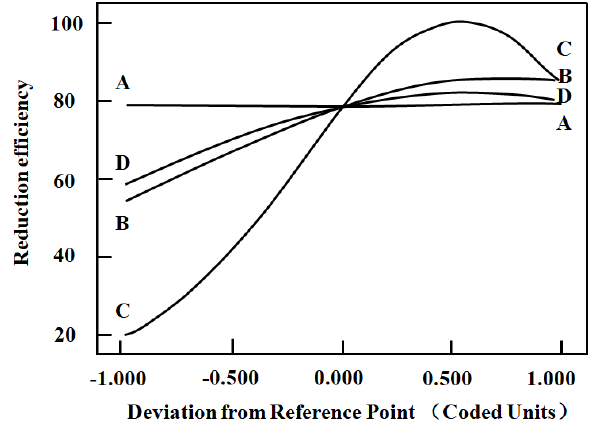
Figure 4. Perturbation plot for the precipitation efficiency of vanadium (initial pH of vanadium solution ( A ), reaction temperature ( B ), n(O)/n(V) ( C ) and reaction time ( D )).